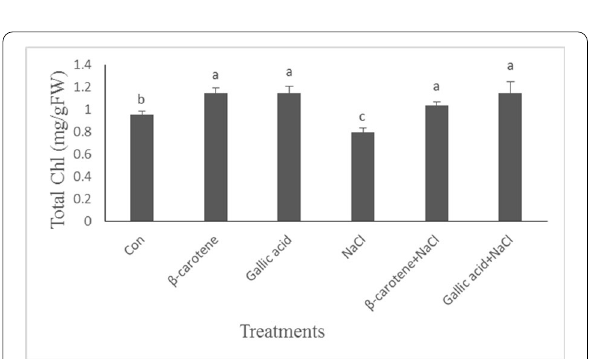
Fig. 3 Effect of β‑carotene and gallic acid, under saline and non‑saline conditions on the total chlorophyll concentration in Lepidium sativum seedlings. Columns with the same letters are not statistically different at 5% probability using Duncan’s test